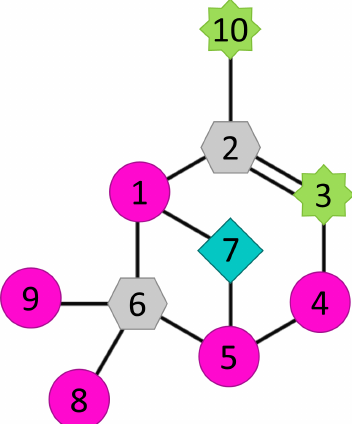
Figure 7. Molecular structure of α -pinene with numbered carbons showing carbons that are active (carbons 3 and 10; green eight-point star) and inactive (carbon 7; light-blue diamond) in the formation process, carbons that were not inspected in this study (carbons 1, 4, 5, 8, and 9; magenta circle), and carbons that cannot be studied using selective deuteration (carbons 2 and 6; grey